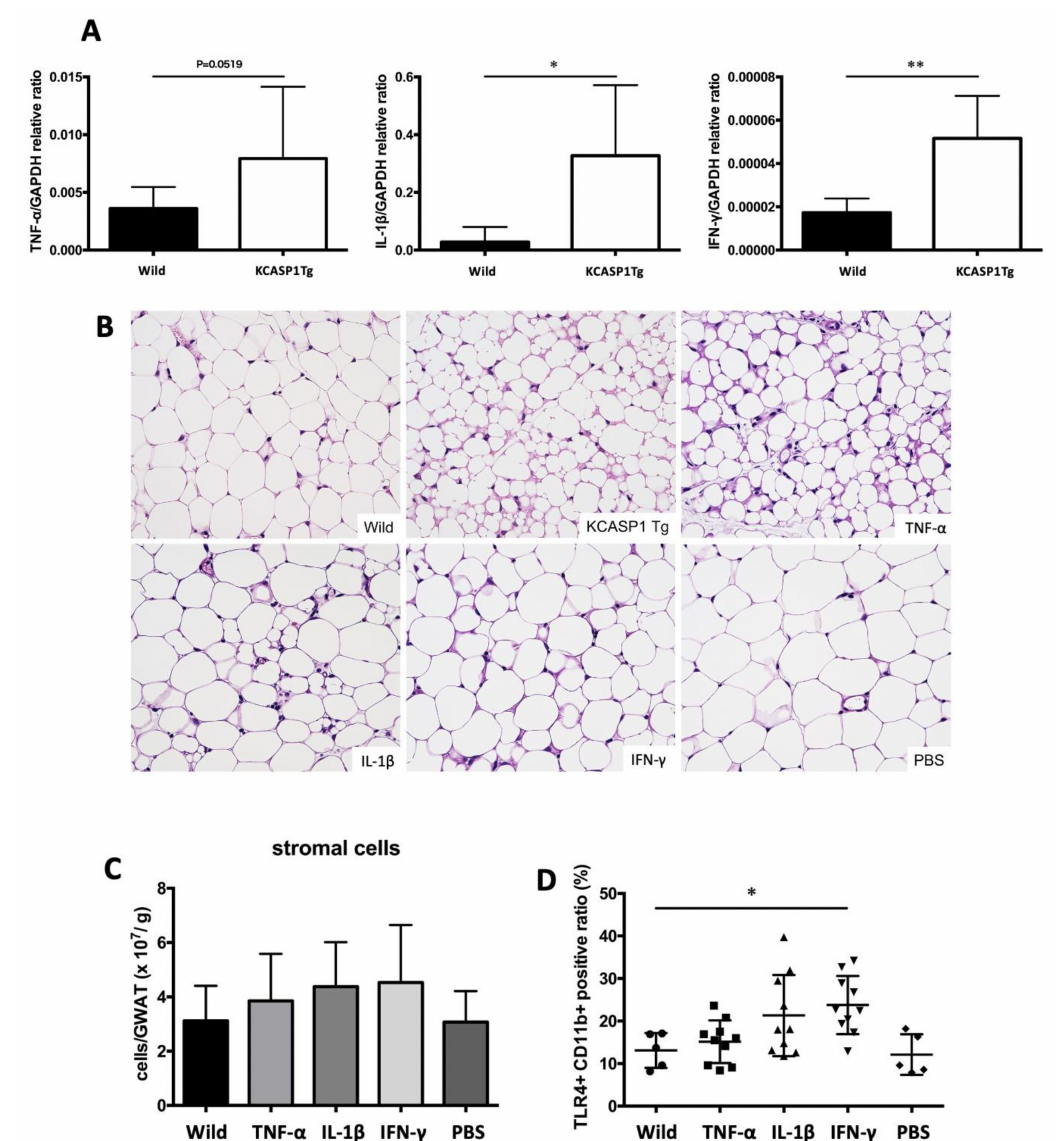
Figure 5. Production of inflammatory cytokines in the skin and the direct e ff ect on AT. ( A ) The TNF α , IL-1 β and INF- γ levels were significantly increased in KCASP1Tg mouse ear skin lesions. ( B ) Eight-week-old BL / 6 wild mice were treated by intraperitoneal injections of TNF- α , IL-1 β , IFN- γ (250 µ g / kg body weight / each time) or PBS three times per week for two weeks. The AT of TNF- α -treated mice showed a similar appearance to that of KCASP1Tg mice; IL-1 β - and IFN- γ -administrated mice also showed a similar trend; adipocytes were large in number, small and irregularly shaped (HE, × 400). ( C , D ) The number of infiltrating cells in GWAT was counted, and the infiltrating cells were analyzed by flowcytometry. The number of infiltrating cells in GWAT was increased in cytokine-administrated mice, while TLR4 + CD11b + activated monocytes were significantly increased in IFN- γ -treated mice. n = 5 per group. * p < 0.05, ** p < 0.01 versus